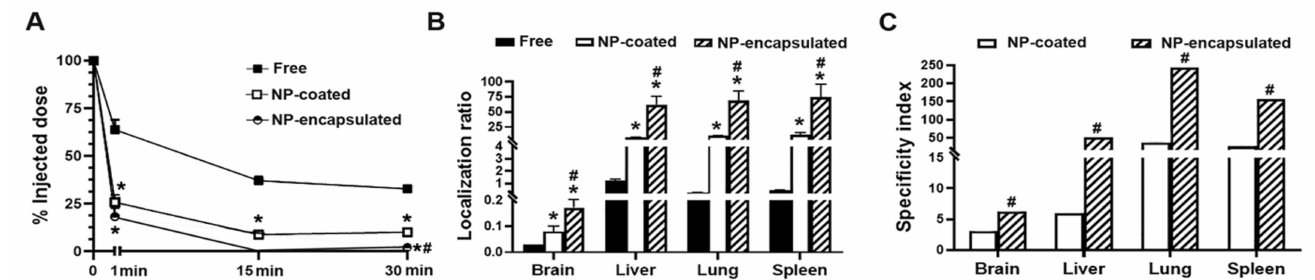
Figure 6. In vivo biodistribution of ASM encapsulated vs. coated anti-ICAM PLGA NP formulations. Wildtype C57B/6 mice were i.v.-injected with 200 µ g/kg body weight 125 I-ASM, administered either as a free enzyme or coated on or encapsulated in anti-ICAM PLGA NPs. ( A ) Enzyme presence in blood was analyzed at the indicated times using a gamma counter and expressed as the percentage of the injected dose (% ID). ( B ) Enzyme biodistribution in the indicated organs was assessed 30 min after injection and expressed as the tissue-to-blood localization ratio (see Materials and Methods). ( C ) The specificity index was calculated as the localization ratio of respective NP formulation over the localization ratio of the free enzyme. Data are the mean ± SEM ( n ≥ 4; non-visible error bars are hidden by the data symbol) and statistics were assessed by Student’s t -test ( p < 0.05). * Compares each NP formulation vs. free 125 I-ASM at respective times and locations; # Compares NP encapsulated vs. coated enzyme for respective times and